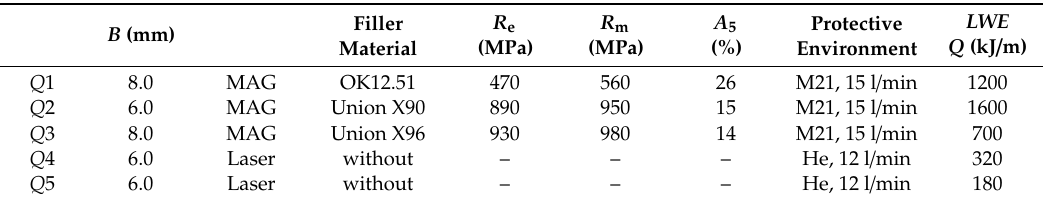
Table 1. Parameters of welding processes of S960